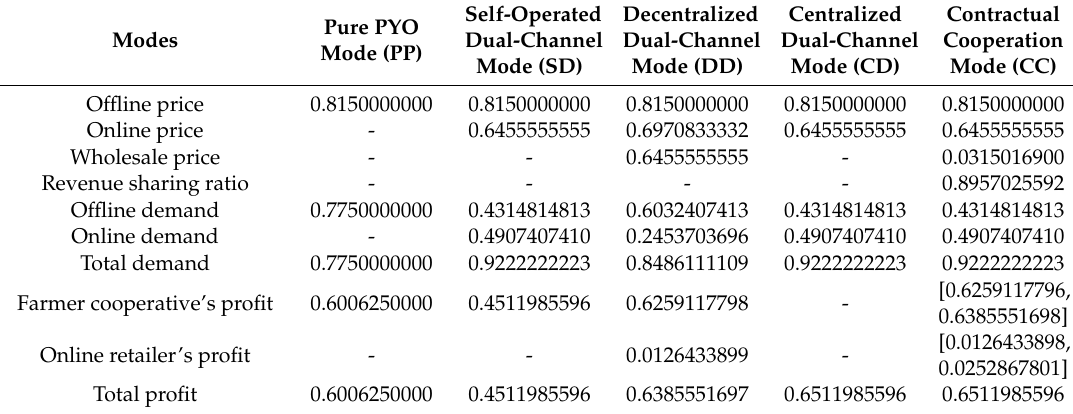
Table 4. Price, demand, and profit under di ff erent